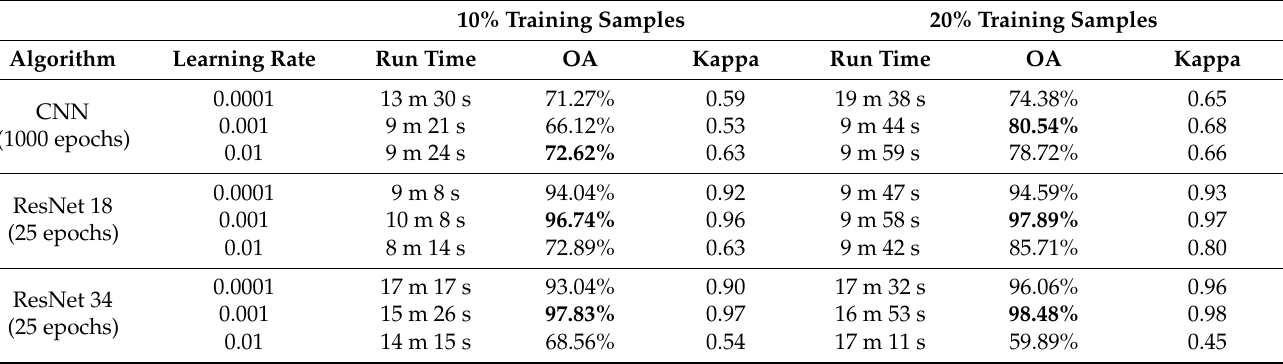
Table 3. Comparison of overall accuracy, Kappa statistic, and run time for CNN, ResNet 18, and ResNet 34 with three different learning rates and two different training